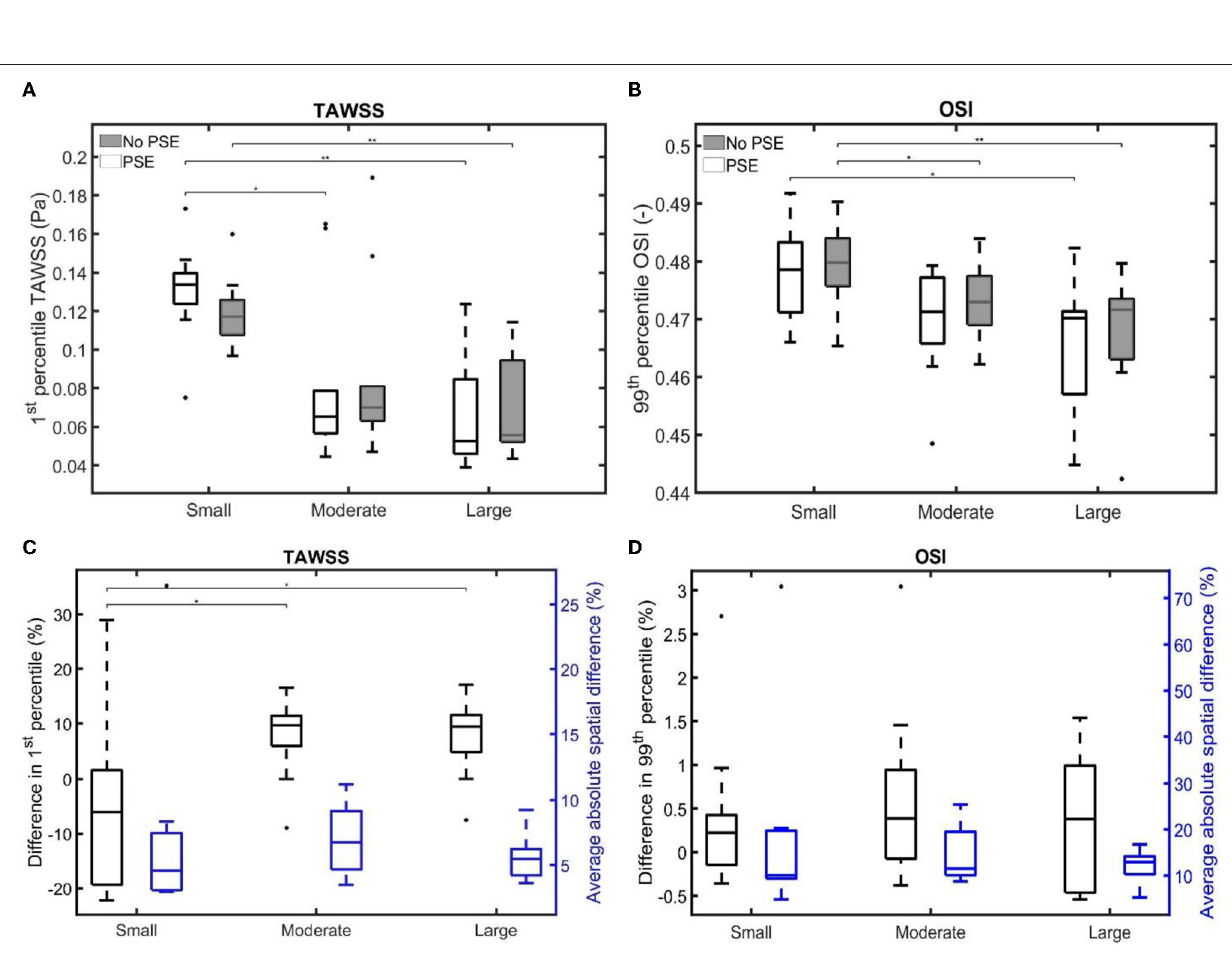
Frontiers in Physiology |